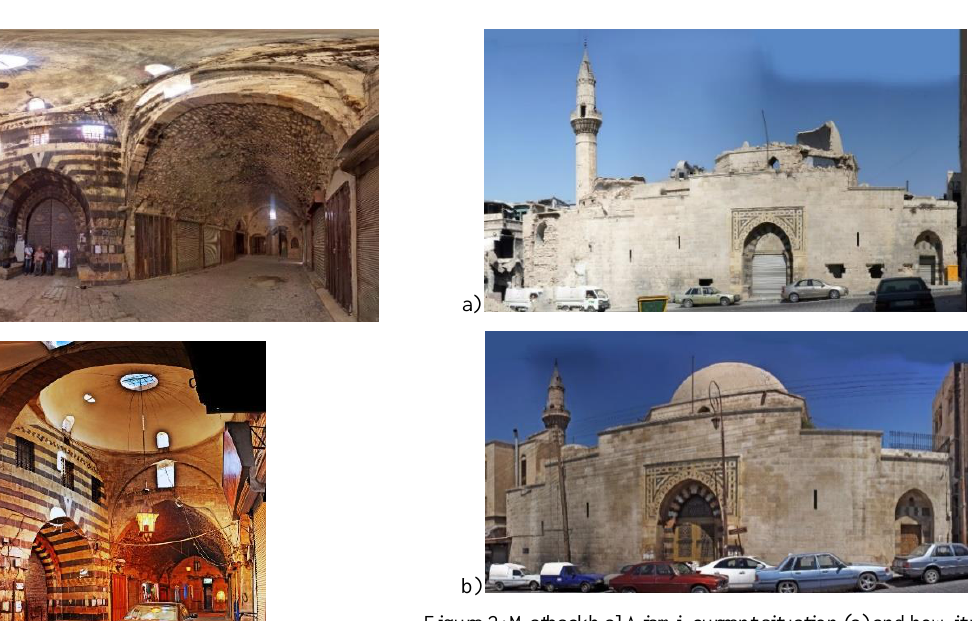
Figure 2: Matbackh al Ajami, current situation (a) and how it was in 2010 (b).